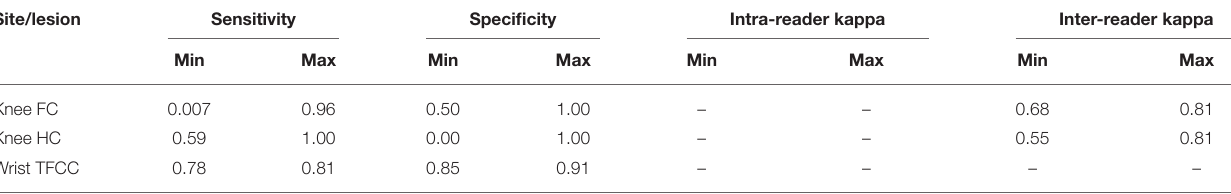
TABLE 8 | Performance of ultrasound to detect CPPD elementary lesions and reproducibility. Site/lesion Sensitivity Specificity